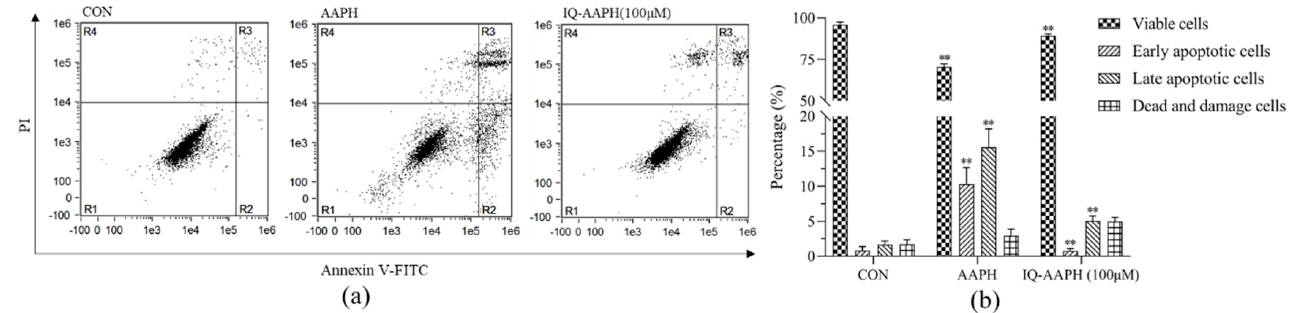
Figure 2. Effect of IQ on AAPH-induced apoptosis cycle of MC3T3 cells. ( a ) Apoptosis detected by flow cytometry; ( b ) statistical analysis of cell proportion in different stages of apoptosis. Experiments were performed in triplicate, and the data were expressed as the mean ± SD, * p < 0.05, ** p < 0.01.